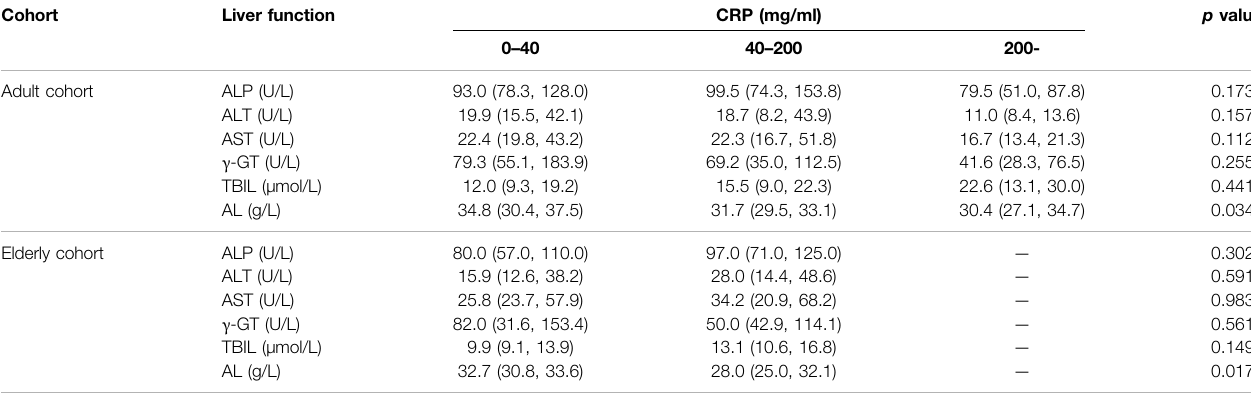
TABLE 3 | Comparisons of liver function under different in fl ammation degrees as re fl ected by CRP levels in the two cohorts. Cohort